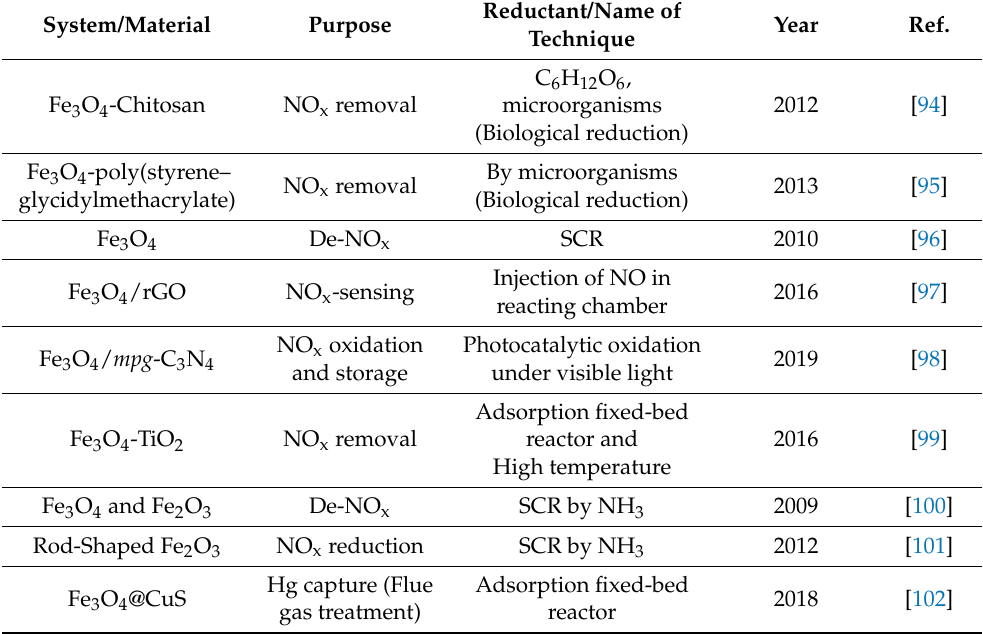
Table 5. Functionalization of Fe 3 O 4 by different organic/inorganic layers used for NO x removal and NO x reduction under different